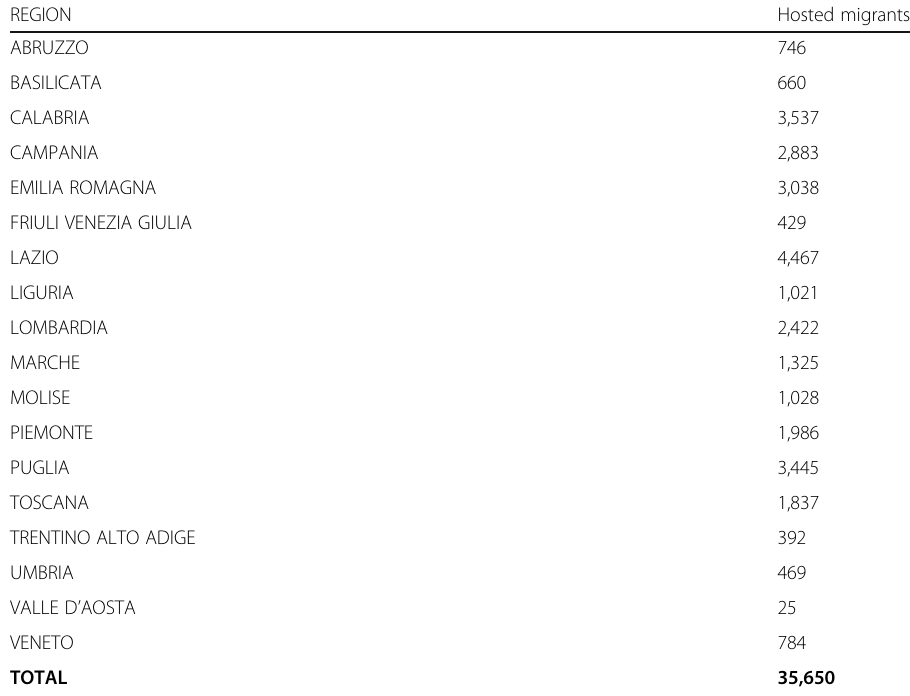
Table 1 Migrants hosted in SPRARs in each Italian region, updated on 19 January 2019 REGION Hosted